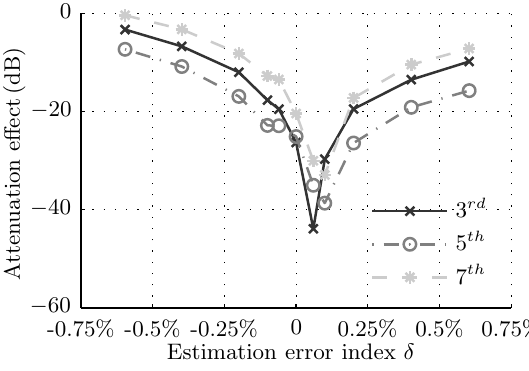
Figure 14. Experimental results of the impact of the grid frequency estimation error on the add-on harmonic